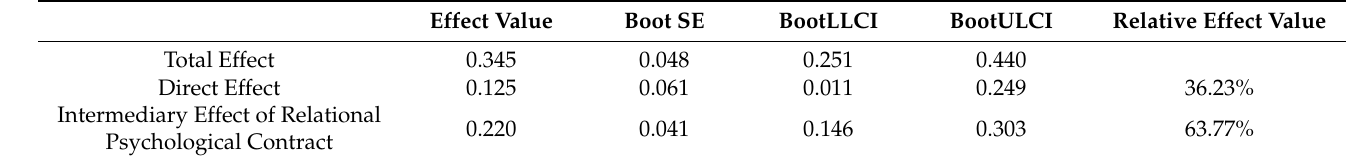
Table 4. Decomposition table of total effect, direct effect and intermediary